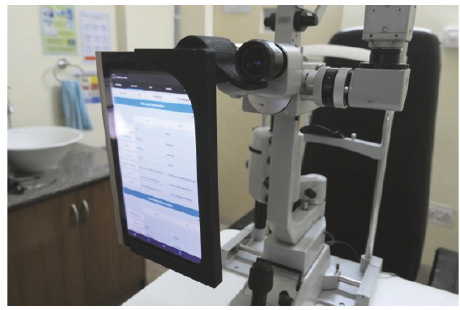
Figure 12: Placement of tablet with attachment.